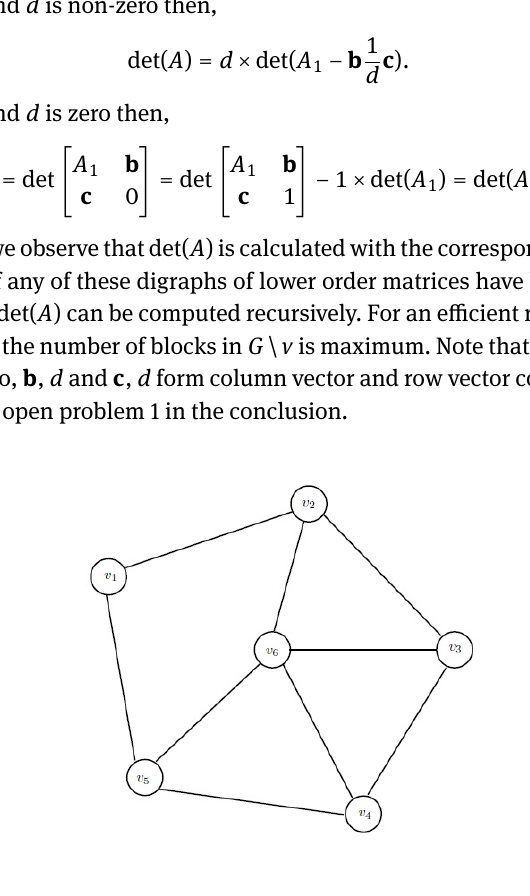
Figure 3: A digraph of order 6 having no